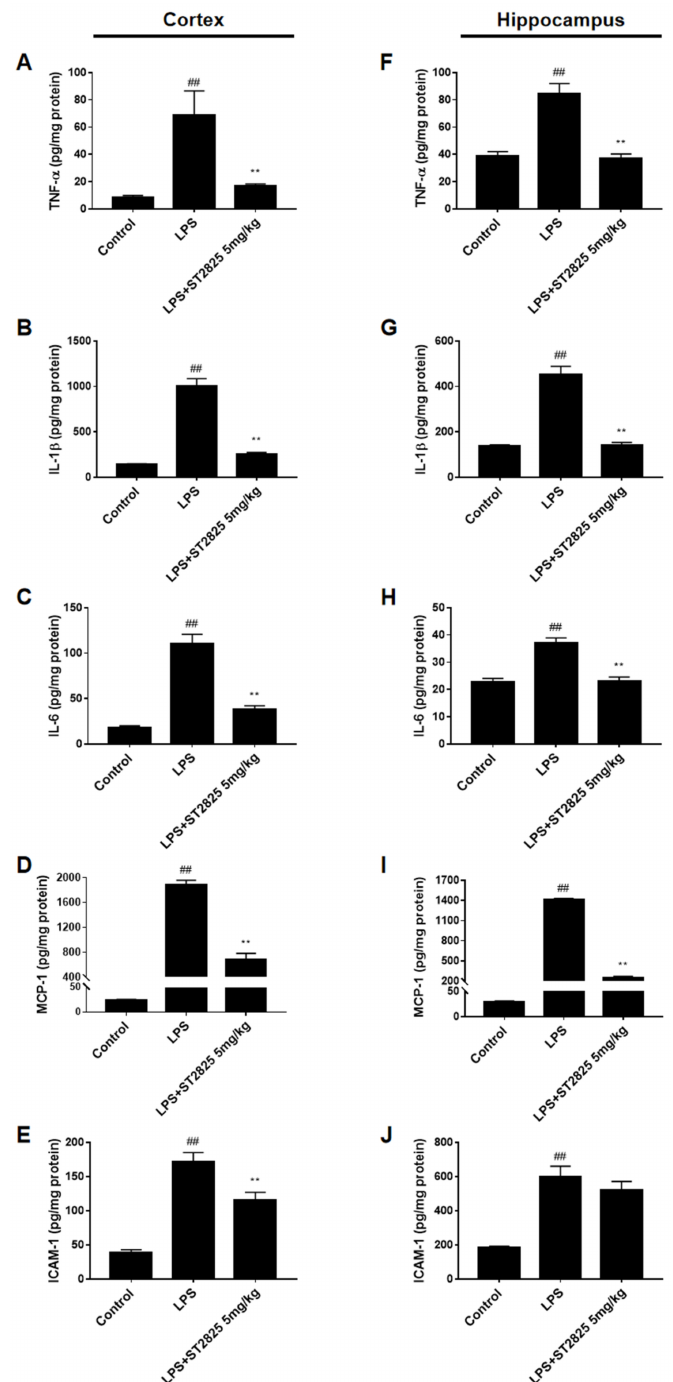
Figure 2. Effects of ST2825 on LPS-induced pro-inflammatory factors in BALB/c mice. The levels of ( A ) TNF- α , ( B ) IL-1 β , ( C ) IL-6, ( D ) MCP-1, ( E ) ICAM-1 in the cortex and ( F ) TNF- α , ( G ) IL-1 β , ( H ) IL-6, ( I ) MCP-1, ( J ) ICAM-1 in the hippocampus were assessed by ELISA. Values are mean ± SEM ( n = 6). ## p < 0.01 vs. control group; ** p < 0.01 vs. LPS